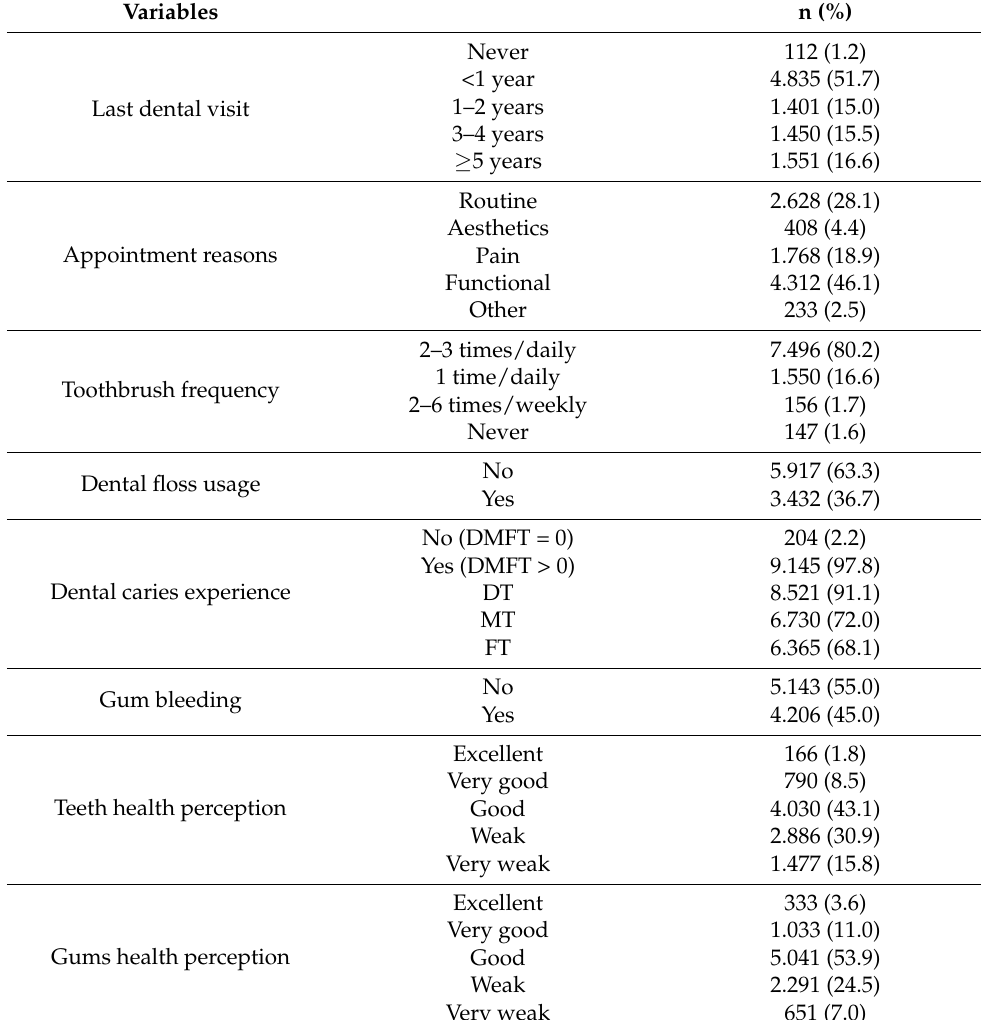
Table 2. Oral health care, dental caries experience, and self-reported perception about oral health condition descriptive data (n =